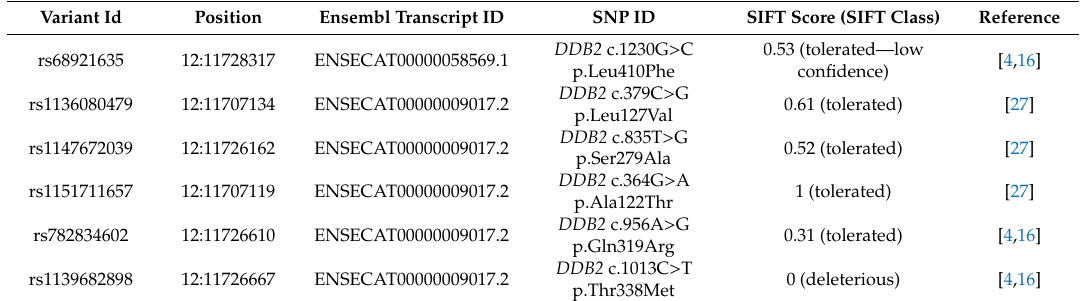
Table 5. Missense variants identified in damage-specific DNA binding protein 2 ( DDB2